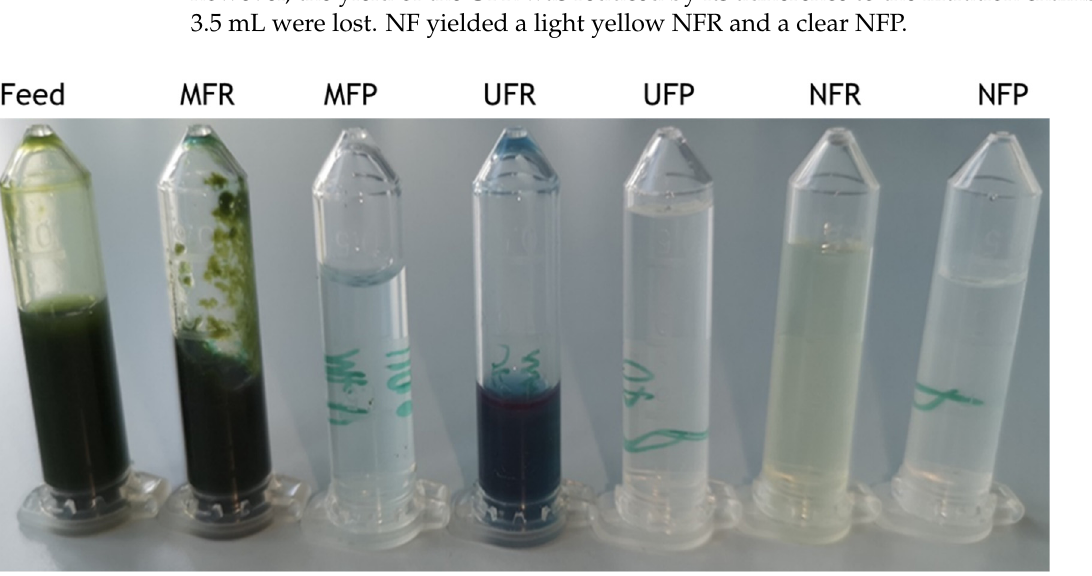
Figure 3. Different fractions obtained during the three membrane filtrations. From left to right: C. fritschii feed solution, microfiltration retentate (MFR), microfiltration permeate (MFP), ultrafiltration retentate (UFR), ultrafiltration permeate, (UFP), nanofiltration retentate (NFR) and nanofiltration permeate (NFP).